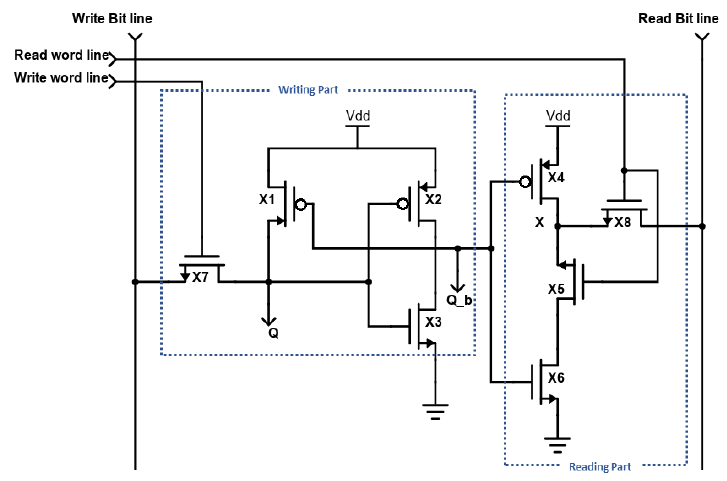
Figure 13. Proposed SE 8T SRAM cell.